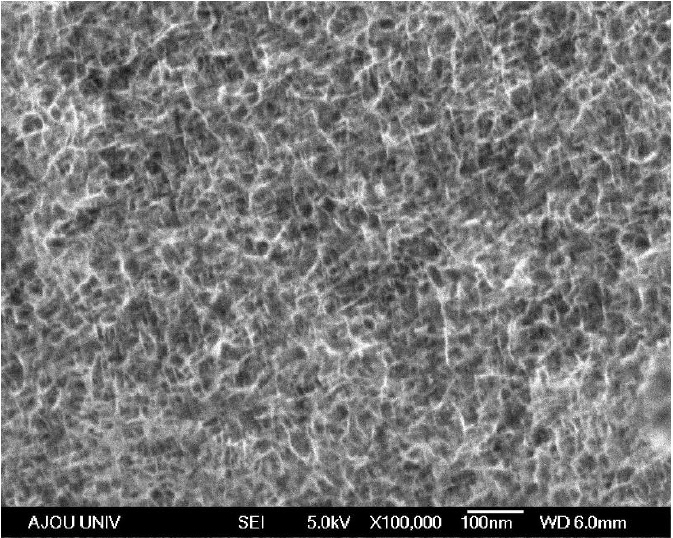
Figure 1. SEM image of the electrodeposited Mn-Ni oxide